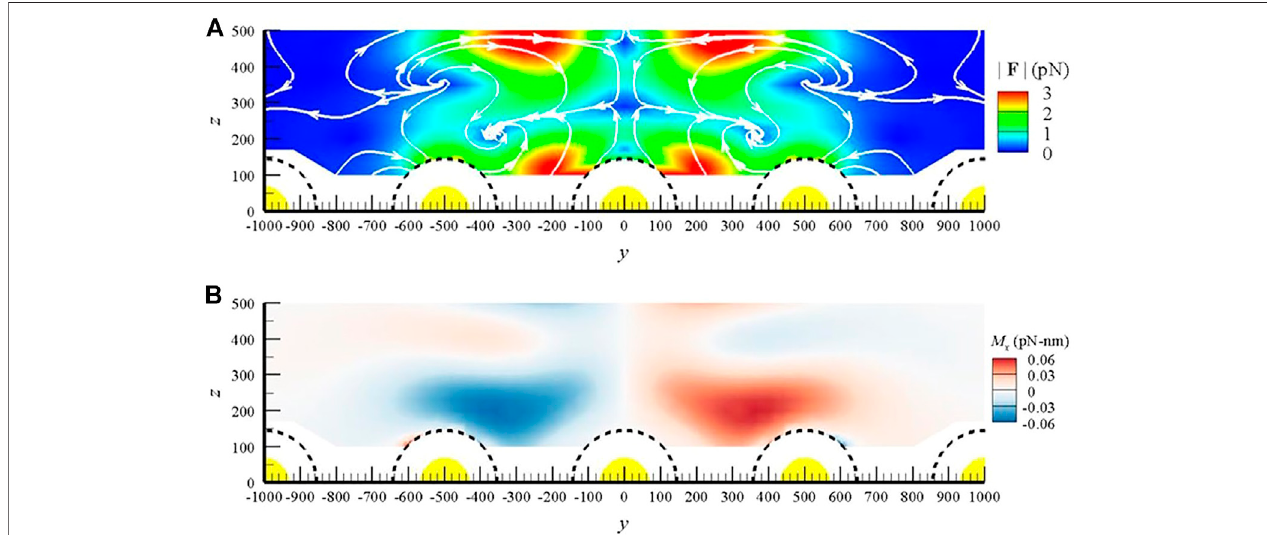
y , F z )appliedto